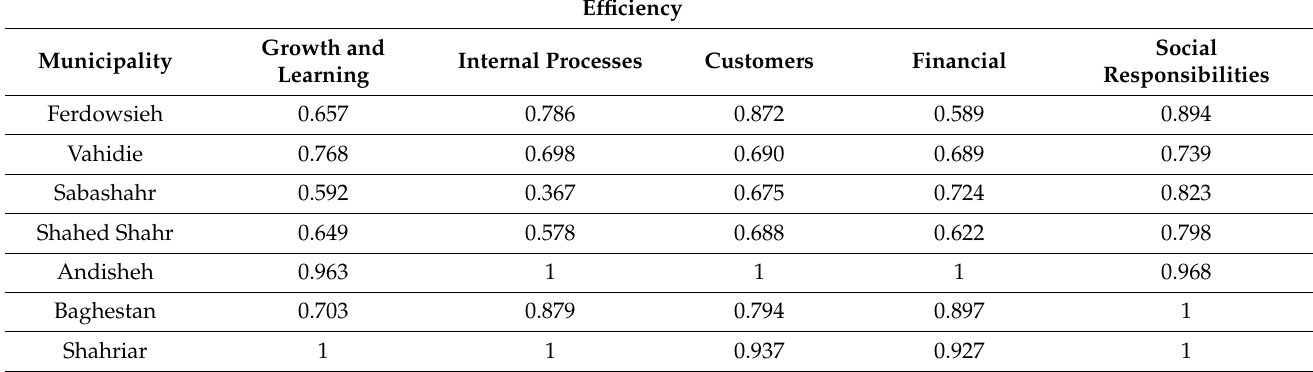
Table 7. Evaluation